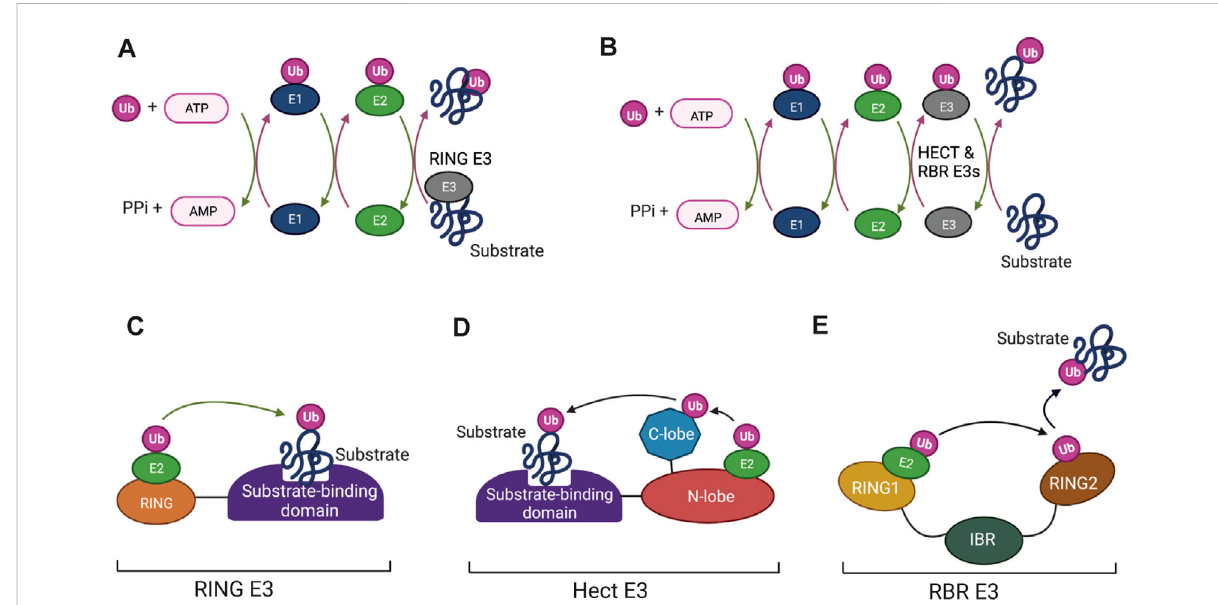
The enzymes that mediate protein ubiquitination: (A,B) The enzyme cycles for ubiquitination involving RING fi nger E3 ligases (A) and HECTand RING-Between-RING (RBR) E3s (B). Ubiquitin is fi rst activated by the ATP-dependent formation of a thioester bond to a cysteine residue in the E1 enzyme. This is followed by conjugation of the activated ubiquitin to the active-site cysteine of the E2 enzyme via a transthiolation reaction. Binding of E2-Ub conjugates to RING fi nger E3s (A) allows direct transfer of Ub to bound substrates. Ubiquitination mediated by HECT and RBR E3s (B) involves formation of transientthioester intermediates betweenubiquitinand cysteineresiduesin theE3s followedby transfer from the E3to the protein substrates. (C – E) Domain structures of the different categories of E3. (C) RING fi nger E3s consist of a RING domain that binds the E2-UB conjugateandpositionsitfortransfertothesubstrate. (D) HECTE3scontainaHECTdomain,whichconsistsofN-terminalandC-terminallobes.The E2-Ub conjugate binds to the N-lobe and the ubiquitin then forms a thioester bond with a conserved catalytic cysteine in the C-lobe followed by transfer to the bound substrate. (E) RBR E3s consist of a canonical RING domain (RING1), an In-Between-RING (IBR) domain and a non-canonical RING domain (RING2). The E2-Ub conjugate binds to RING1 and the fl exible inter-domain regions facilitate formation of the intermediate thioester linkage between Ub and a catalytic cysteine located in the RING2 domain. Ub is then transferred from the RING2 domain to the substrate by as yet undetermined mechanisms. Figure created with